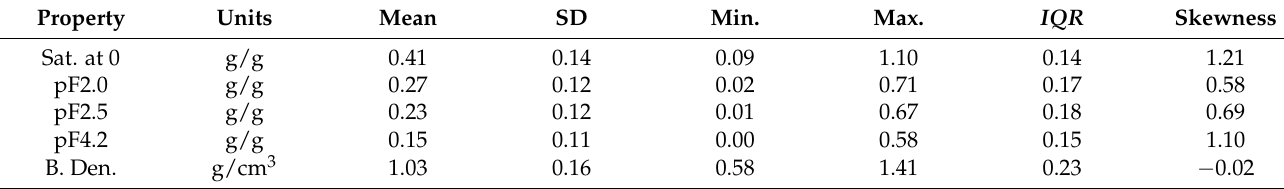
Table A2. Descriptive statistics of properties in the “Water” group.